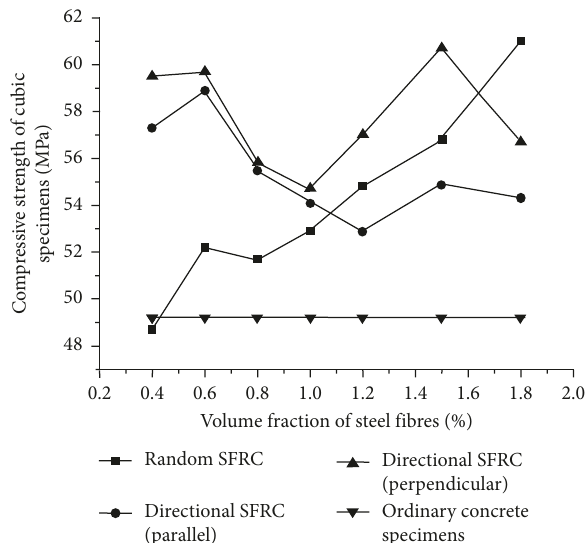
Figure 8: Compressive strengths of cubic specimens with